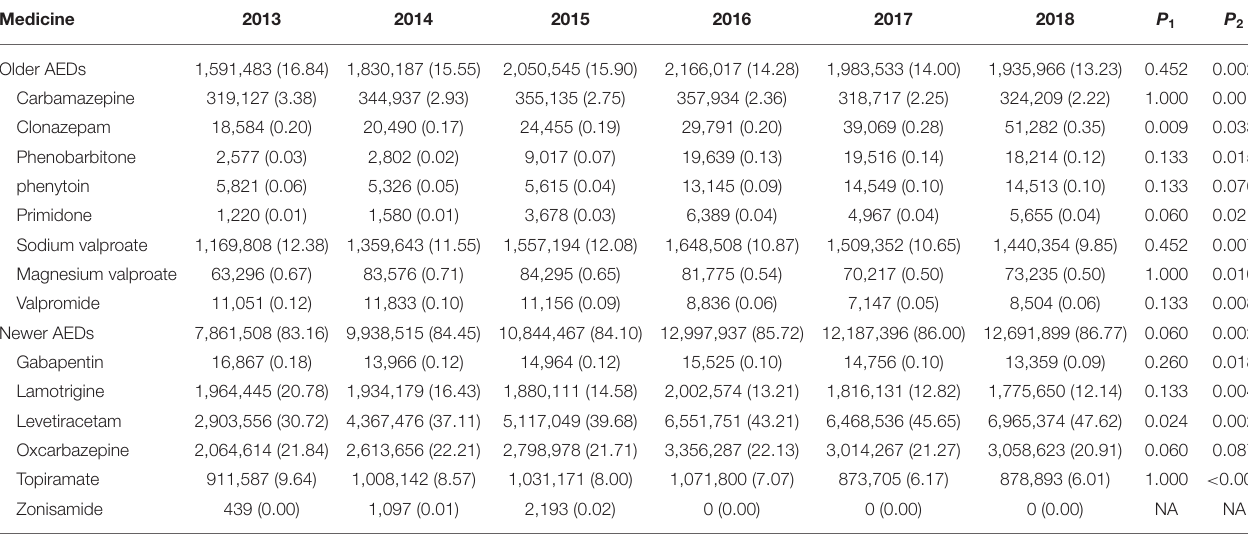
TABLE 3 | Total expenditure on anti-seizure medication (ASM) dispensed from 2013 to